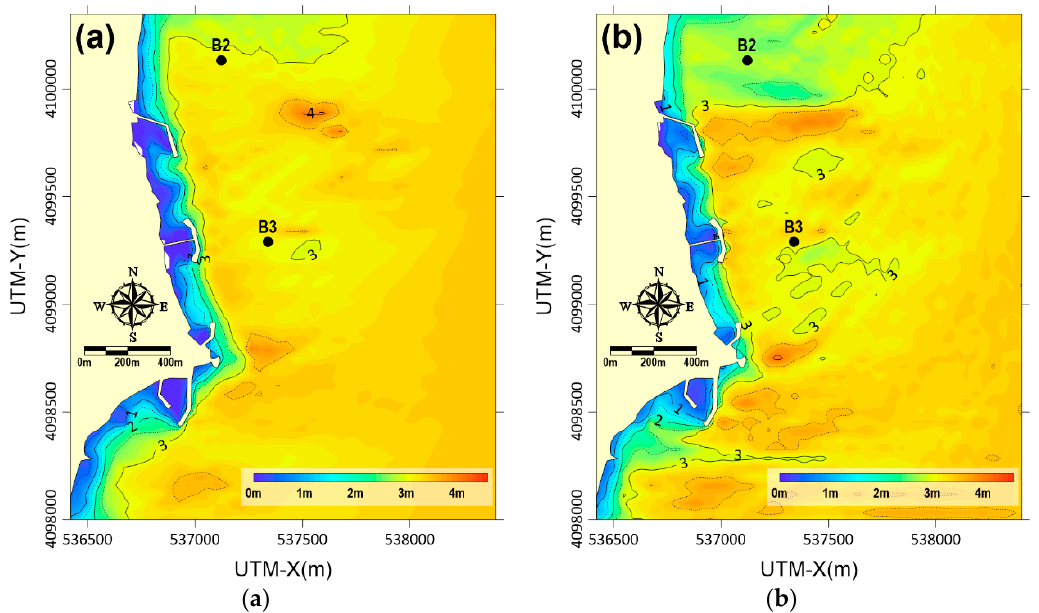
Figure 11. Same as Figure 9 but at a magnified view for comparison of the wave height distributions near the coastal structures, headland breakwaters, and submerged breakwaters, ( a ) TELEMAC– TOMAWAC and ( b ) TEL EMAC–ARTEMIS, Case 2.